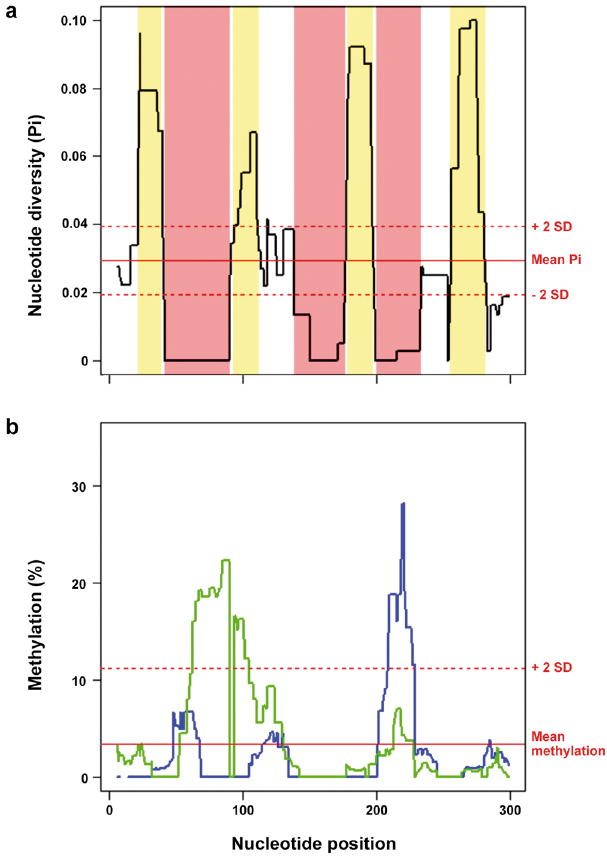
Figure 5. Nucleotide diversity and cytosine methylation throughout SSUsat monomer sequence. Sliding window analysis of the distribution of the nucleotide diversity ( a ), computed using a 10 bp overlapping sliding window, along the SSUsat sequence showing conserved (pinkish) and variable (yellowish) regions; the red lines indicate mean ( ± 2 SD) diversity (Pi). The same type of analysis applied to the proportion of methylated cytosines ( b ), also computed using a 10 bp overlapping sliding window, for direct (green line) and complementary (blue line) strands of the SSUsat; red lines indicate mean ( + 2 SD) methylation